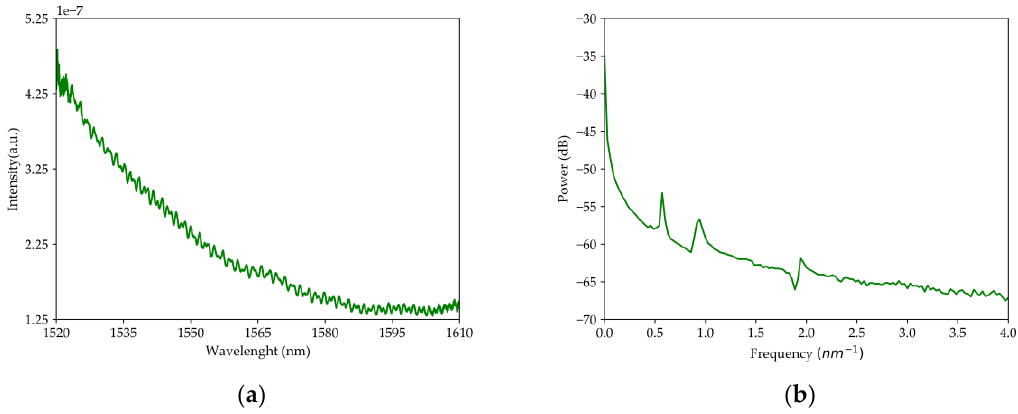
Figure 3. ( a ) Spectral response of the interferometer; ( b ) Fast Fourier Transform (FFT) of Figure 3a.